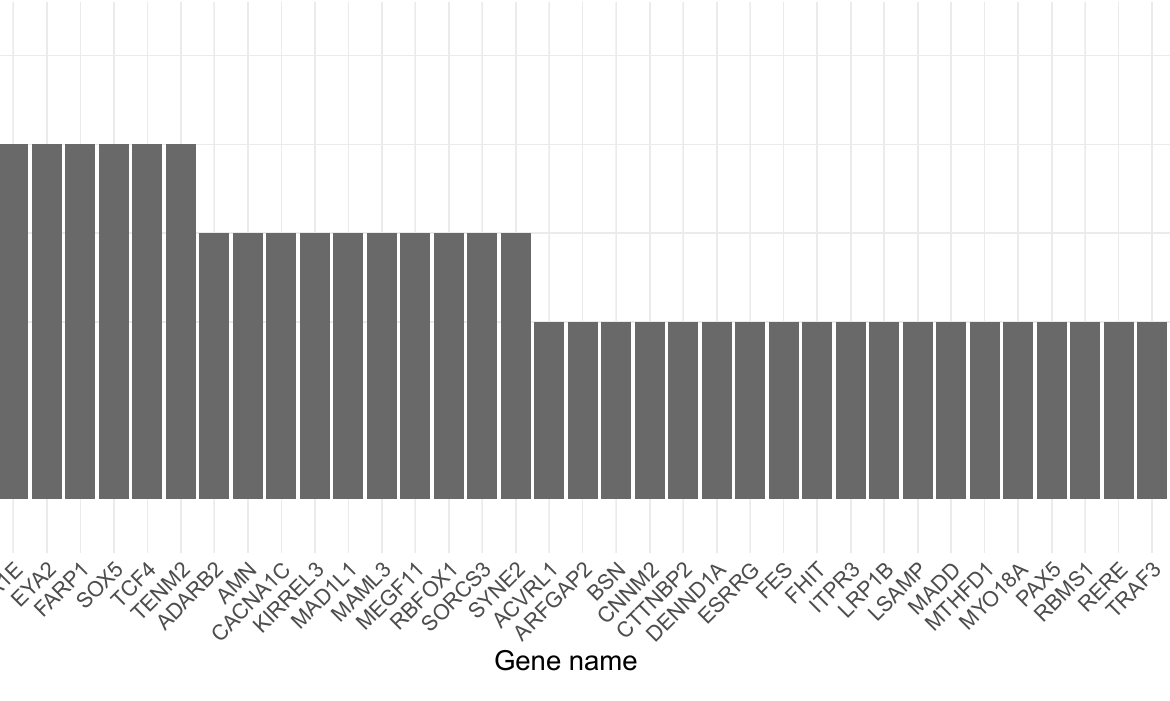
Figure 2. Overview of the genes overlapping between genes residing in MDD-associated loci [18] and genes identified as differentially methylated upon exposure to cannabis or cannabis-derived compounds in two or more epigenome-wide